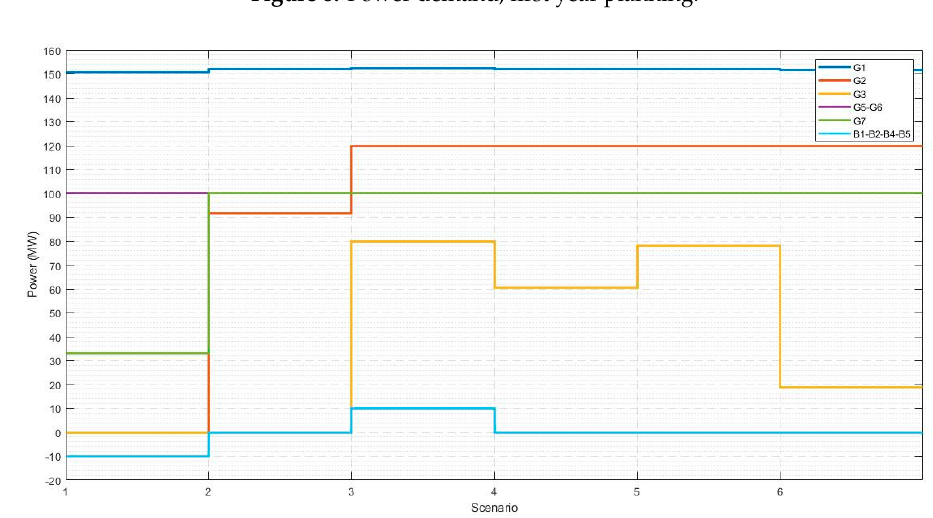
Figure 8. Power demand, first year planning.